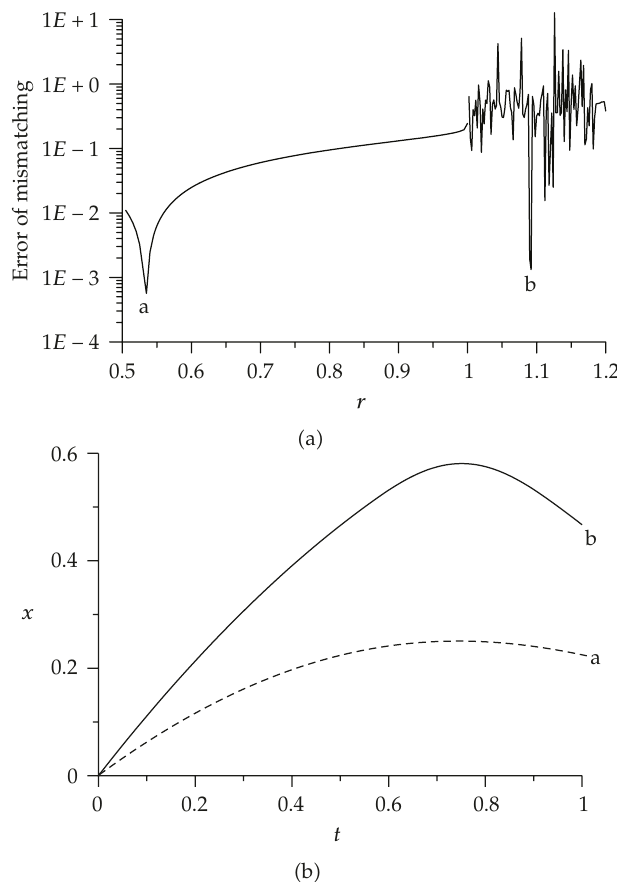
Figure 8: For example 7: (cid:3) a (cid:4) showing the error of mismatching in a larger range, and (cid:3) b (cid:4) showing two numerical